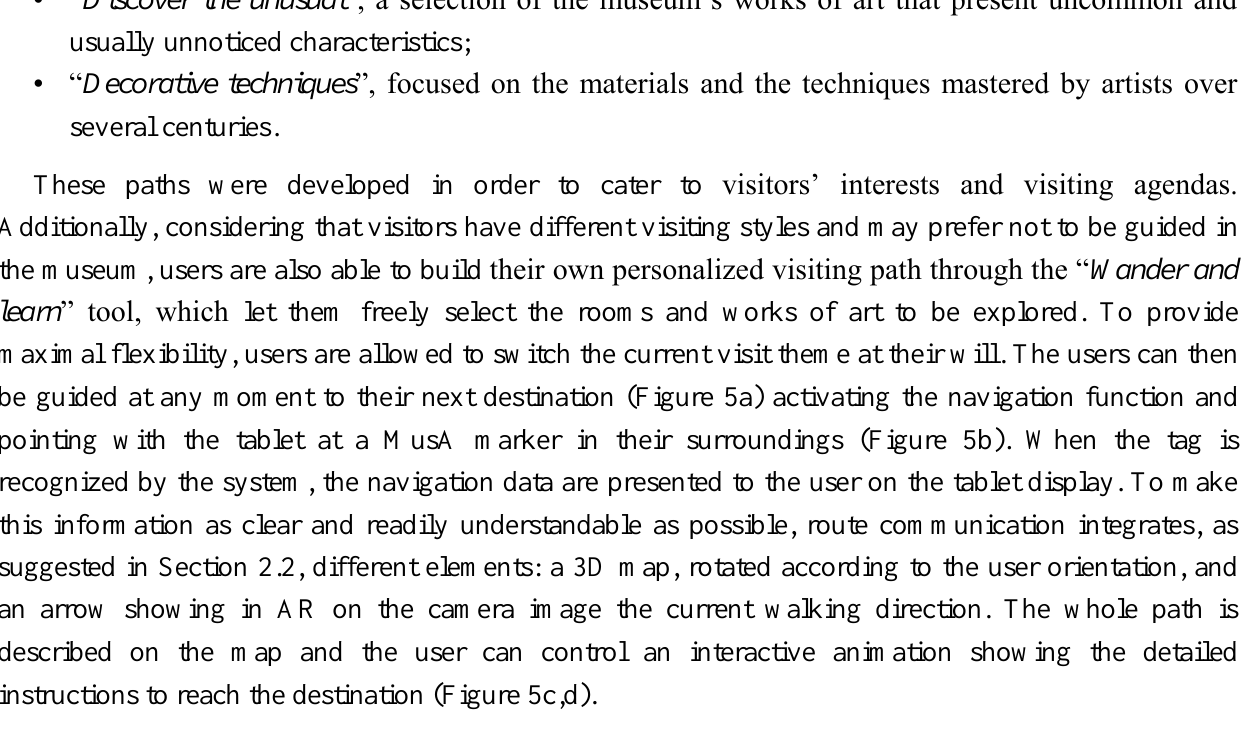
Figure 5. Screenshots of the application interface showing a step of the tour ( a ), the marker aiming menu ( b ), the 3D map and the path animation ( c , d